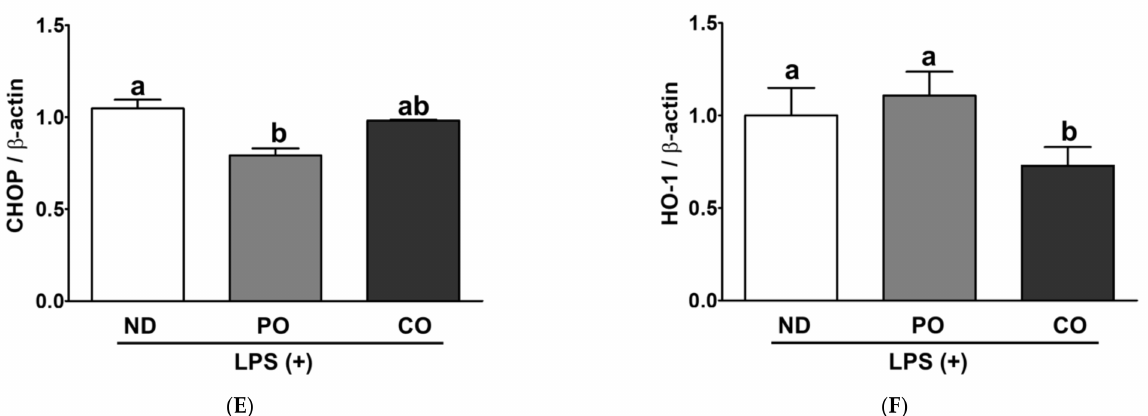
Figure 11. Partial replacement of dietary fat with PO or CO and LPS challenge on the protein expression of inflammatory responses in EAT. Mice were fed either an ND or an ND partially replaced with PO or CO for 12 weeks and then treated with LPS (1 mg/kg) for 24 h ( n = 8 per group). ( A ) Representative Western blot images; ( B ) phospho-extracellular signal-regulated kinase (p-ERK) levels; ( C ) phospho-c-Jun N-terminal kinase (p-JNK) levels; ( D ) binding immunoglobulin protein (BiP) levels; ( E ) C/EBP homologous protein (CHOP) levels; ( F ) heme oxygenase 1 (HO-1) levels. The expression of each protein was normalized to a value for β -actin, the internal control of protein content. Values are presented as the mean ± standard deviation. Data were analyzed using one-way ANOVA followed by Tukey’s post hoc test. Labeled means without a common letter differ ( p <